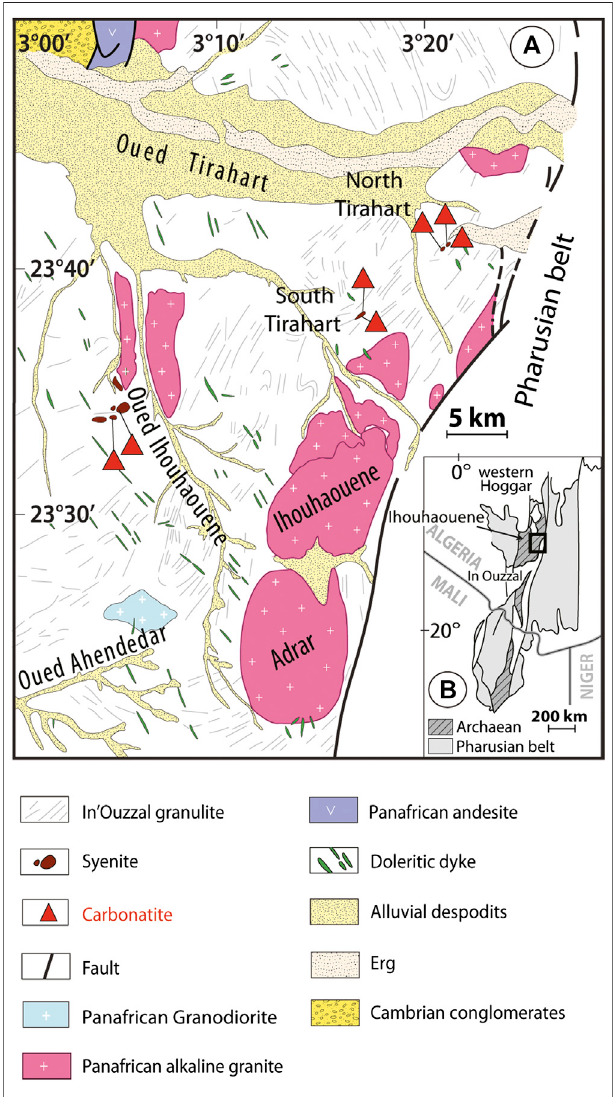
FIGURE 1 | (A) Geological map of the Ihouhaouene area in NW part of the In Ouzzal terrane and localization of carbonatites and associated syenites (modi fi ed after Ouzegane et al., 1988). (B) Position of the Ihouhaouene area in Western Hoggar, south of Algeria (Black et al., 1994).